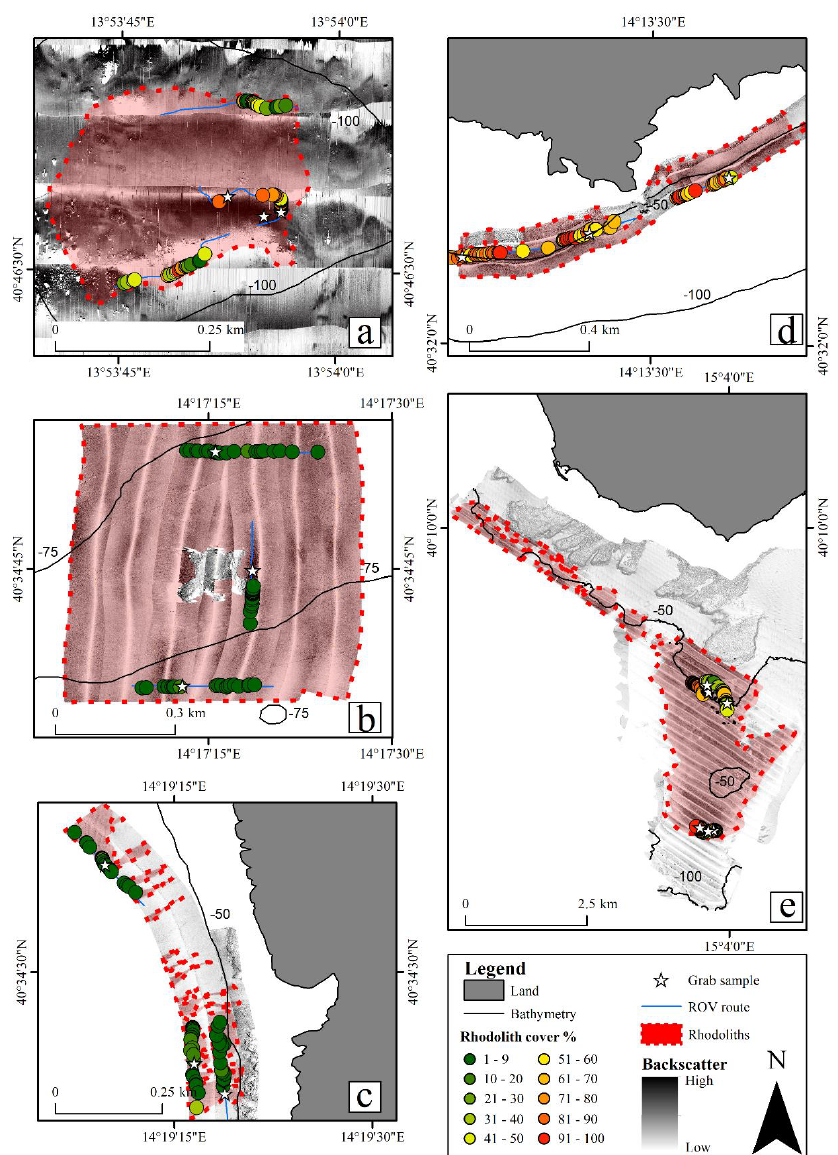
Figure 3. Side-scan sonar images overlaid with maps for the sites of Ischia ( a ), Secchitiello ( b ), Punta Campanella ( c ), Capri ( d ), and Acciaroli A and B ( e ), showing a possible extension of the rhodolith deposits. Red polygons localize the rhodolith deposits. Dotted lines mean that the rhodolith deposits could be wider with respect to the established boundaries. Blue lines and white stars indicate ROV routes and grab sampling points, respectively. Coloured dots indicate the total (live and dead) rhodolith cover (%) of each ROV video frame.